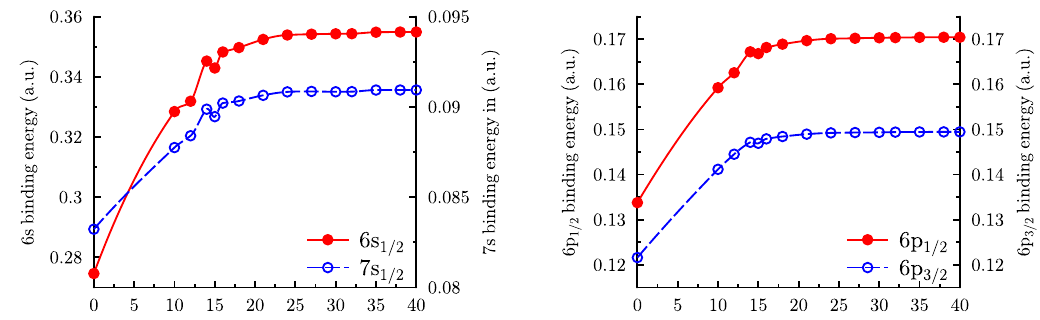
Figure 3. Binding energies for four lower levels of Au calculated within second order MBPT using B-spline basis sets of different length. The x -axis gives the number of virtual orbitals in a partial wave. Zero corresponds to the Dirac–Fock approximation.